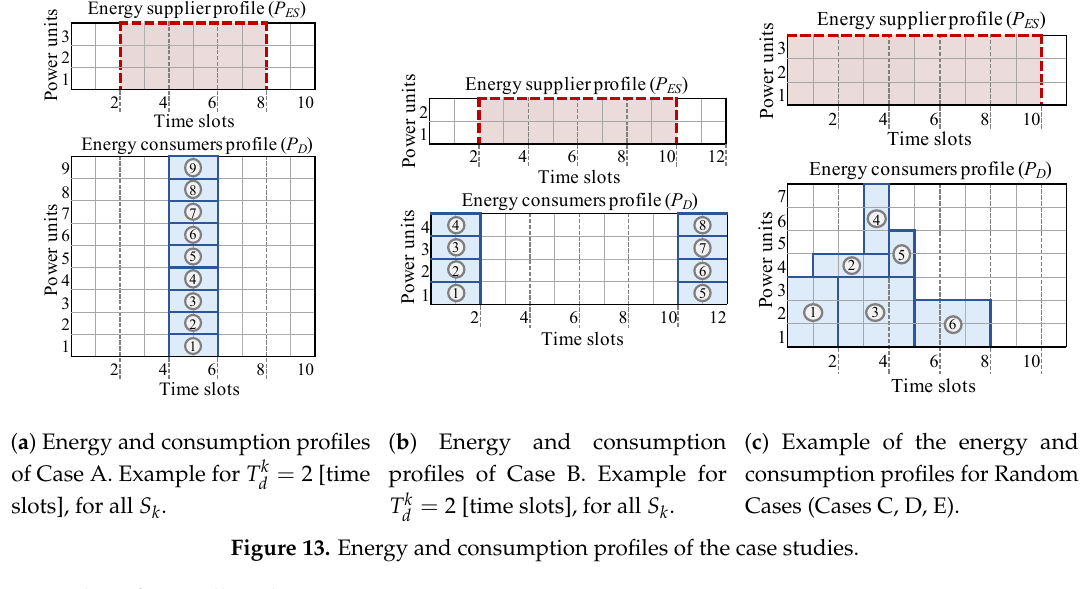
Figure 13. Energy and consumption profiles of the case studies.